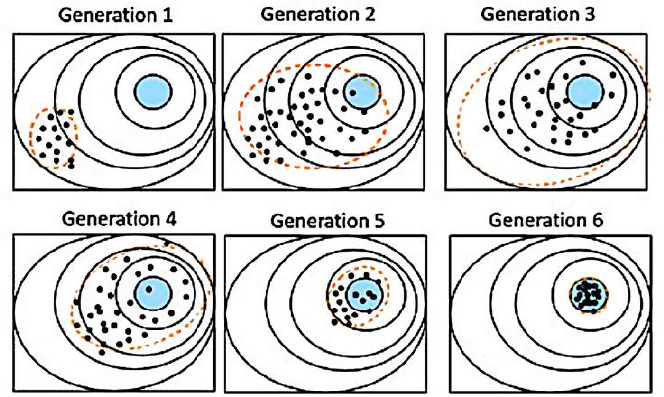
Figure 3. Example of two-dimensional spherical optimization problem. Points are individuals, the blue area is the solution area, and the dashed line is the dispersion calculated with the covariance matrix. Generation 1 shows the initial random distribution. Generations 2–3 show the population moving towards the detected favorable direction of the solution due to the ranking of the individuals. Higher random dispersion is expected as the algorithm looks for other possible minima in the vicinity by “mutation”. In generations 4–6, after the individuals are sufficiently dispersed, with the information of the covariance matrix, the global minimum is pinpointed and all the individuals, regardless of their initial position, converge to the final solution